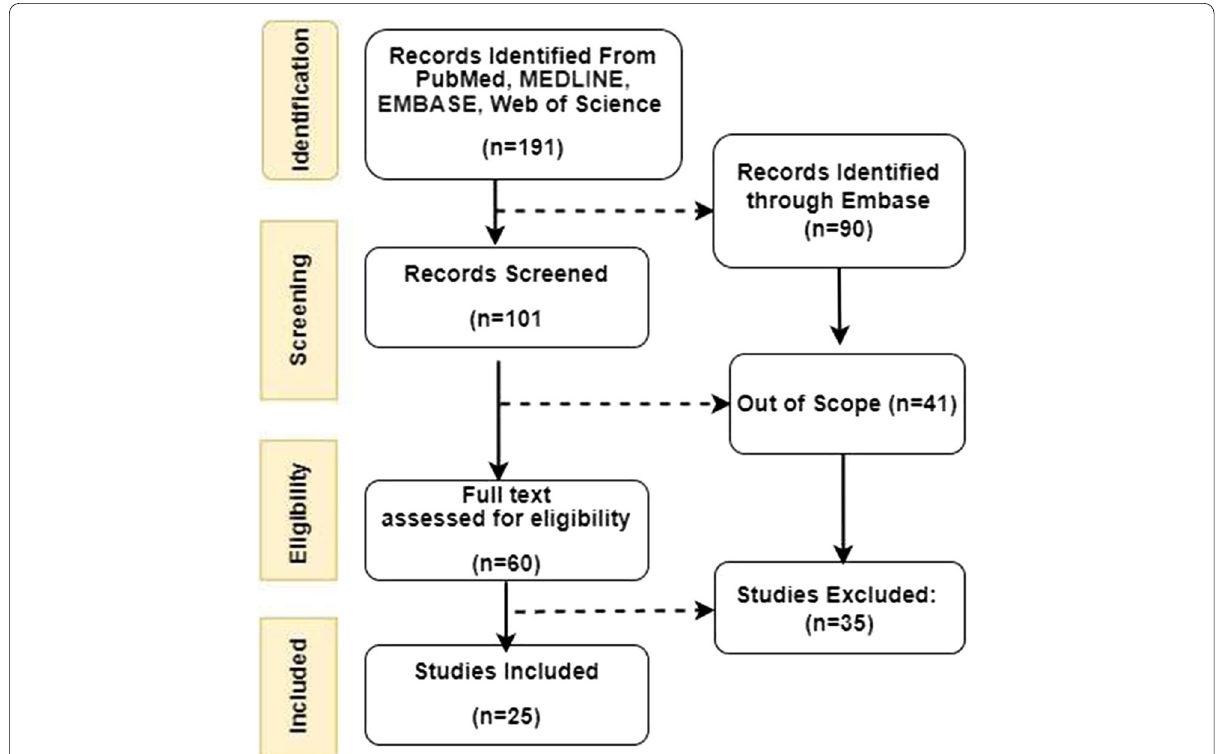
Fig. 1 Identification of studies via database and